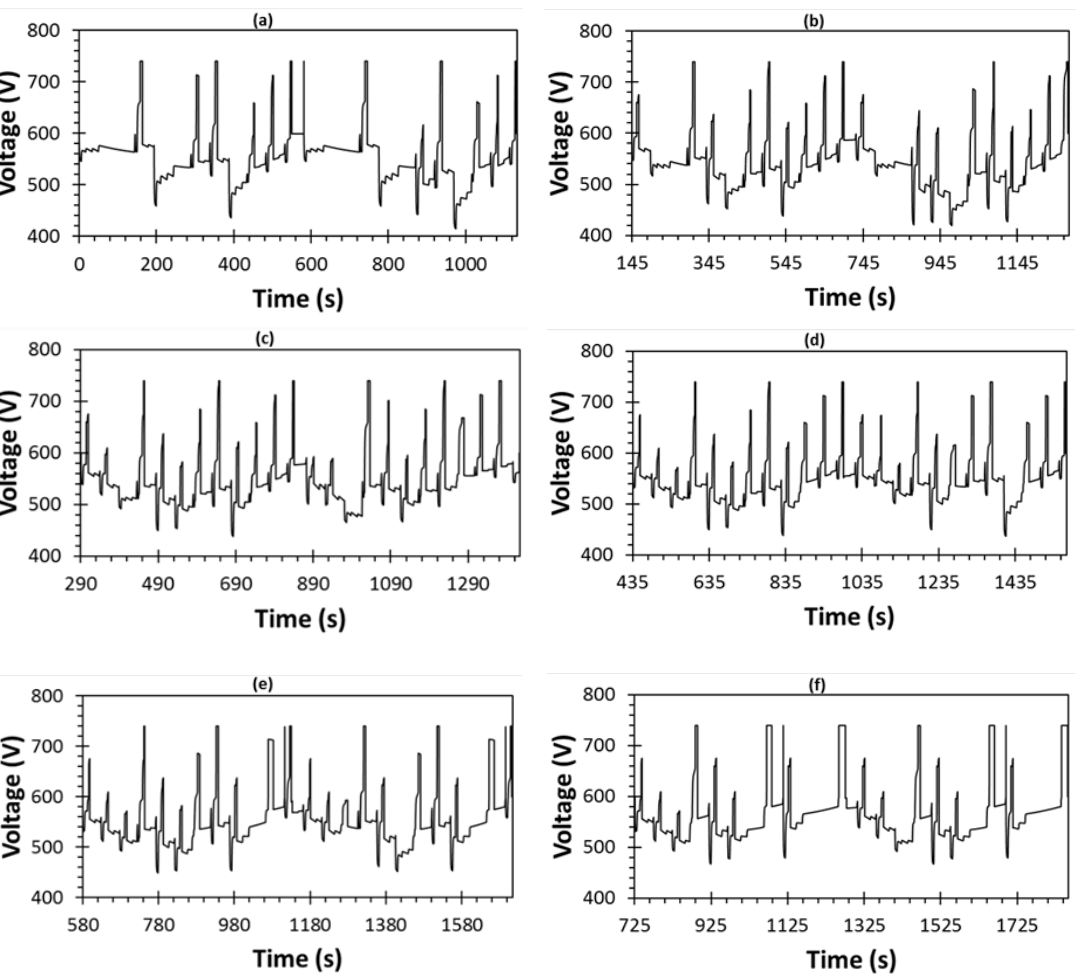
Figure 16. The voltages at the trains’ locations on a single railway track: ( a ) Train 1; ( b ) Train 2; ( c ) Train 3; ( d ) Train 4; ( e ) Train 5; and ( f ) Train 6.